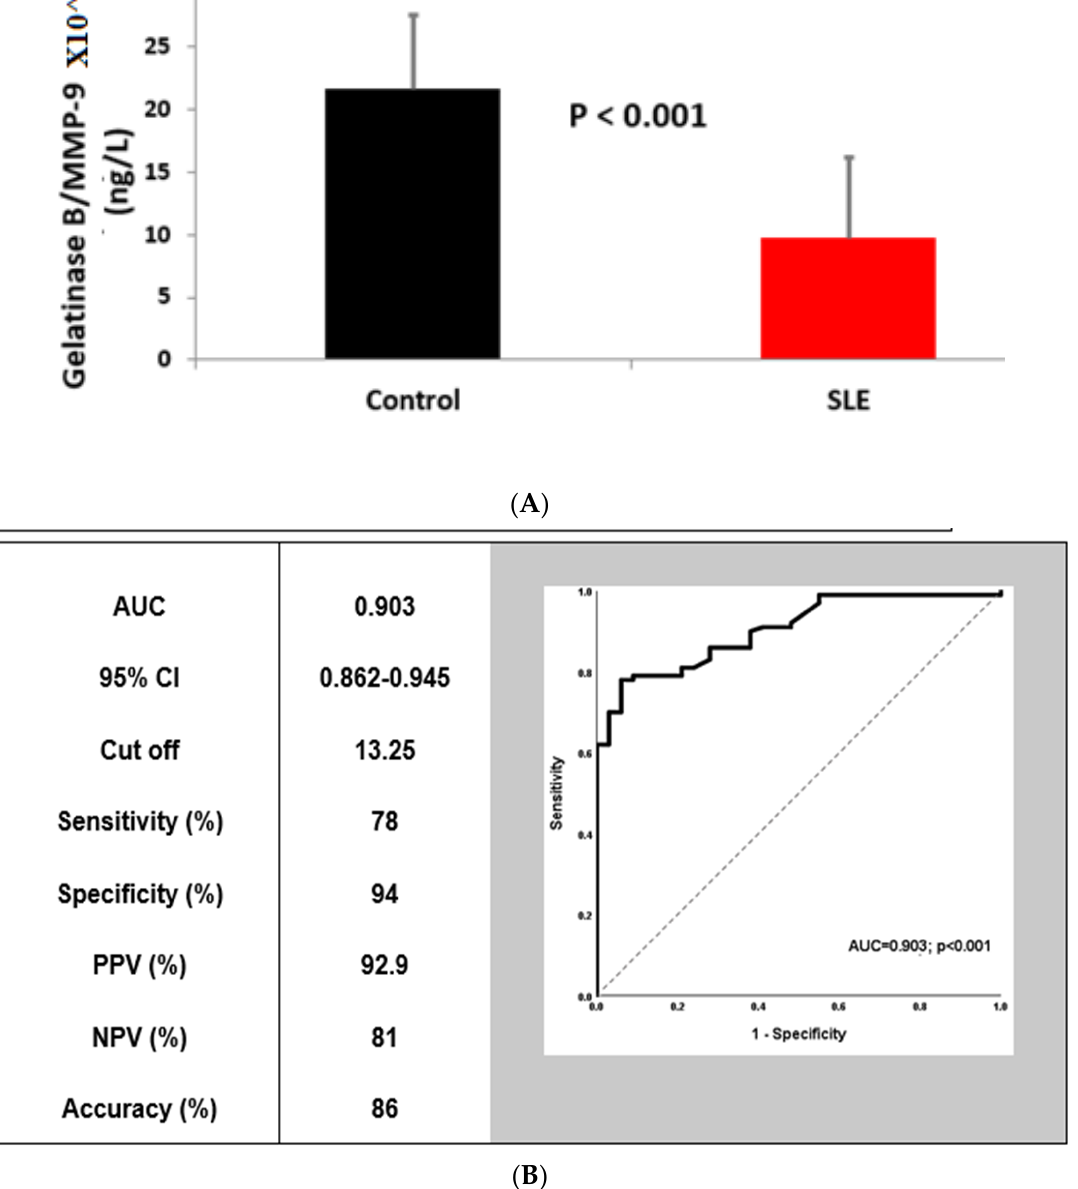
Figure 1. Gelatinase B/MMP-9 ( A ) level (ng/L) in SLE cases and control groups, and ( B ) receiver operating characteristic (ROC) curve of Gelatinase B/MMP-9 level for discrimination between SLE cases and healthy control subjects. Data are expressed as mean ± SD, p < 0.05 versus the control group is considered significant. Abbreviations: PPV stands for positive predictive value; NPV stands for negative predictive value; CI is for confidence interval, AUC: areas under curve.